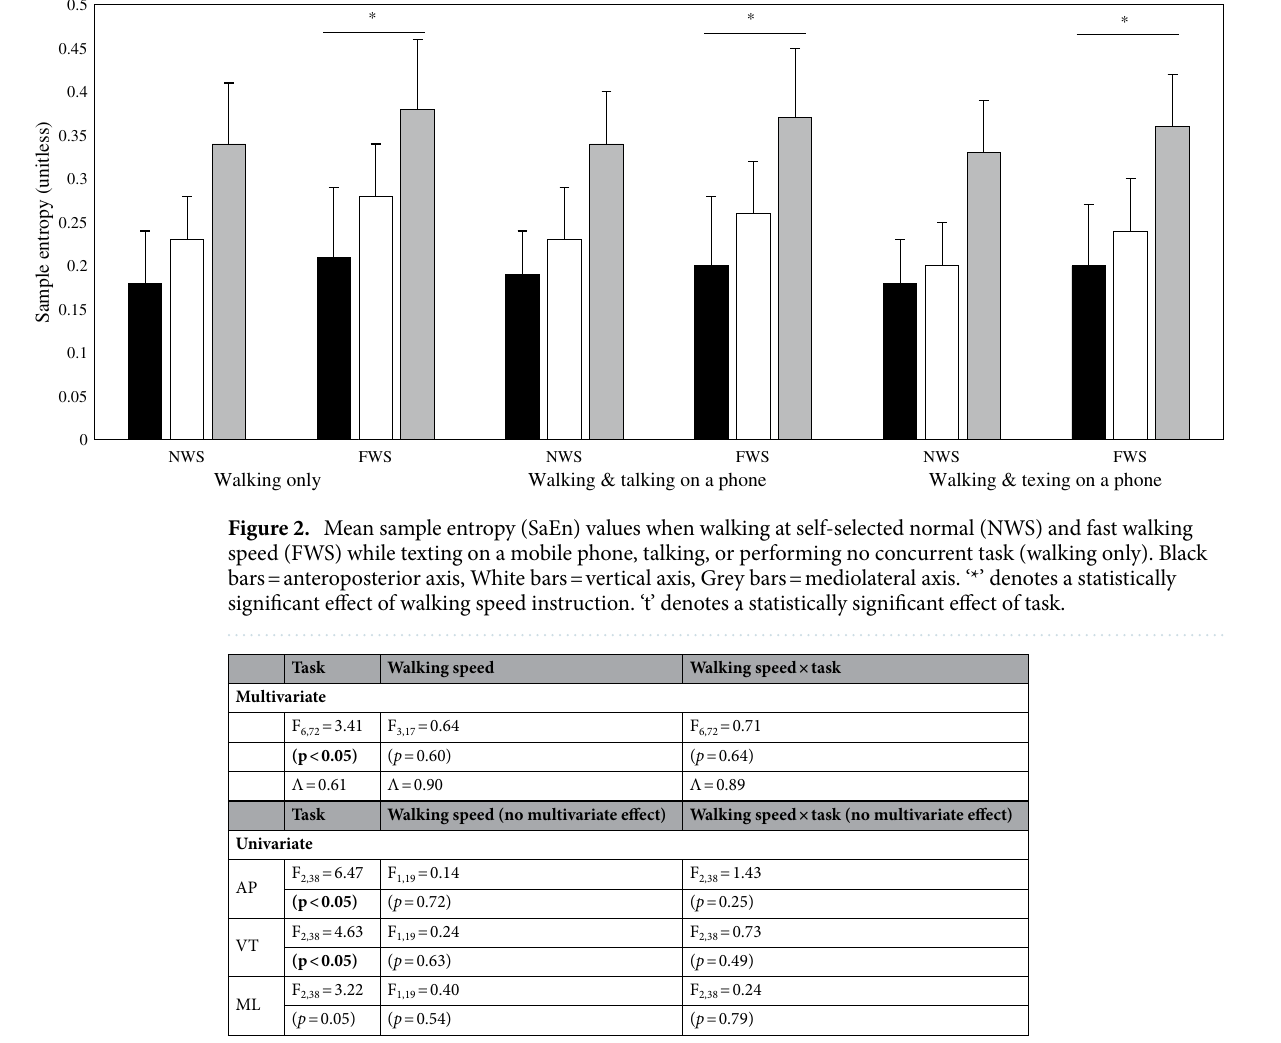
Table 3. Multivariate and univariate analysis results following a 2 × 3 RMANOVA assessing the influence of walking speed instruction and task on the maximum Lyapunov exponent (MaxLyE). ‘Λ’ denotes Wilk’s lambda; ‘F’ denotes the F-statistic (extent of the difference between group means). ‘ p ’ denotes the statistical significance; the threshold for significance was set at p < 0.05. ML mediolateral measurement axis, VT vertical measurement axis, AP anteroposterior measurement